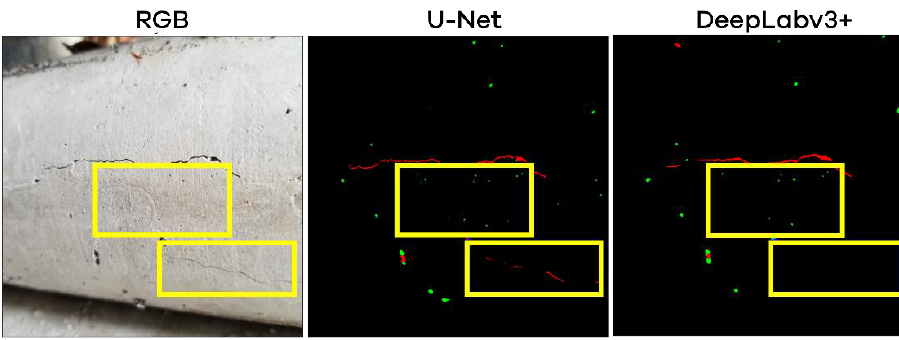
Figure 15. U-Net and DeepLabV3+ comparison on fine-grained object segmentation.